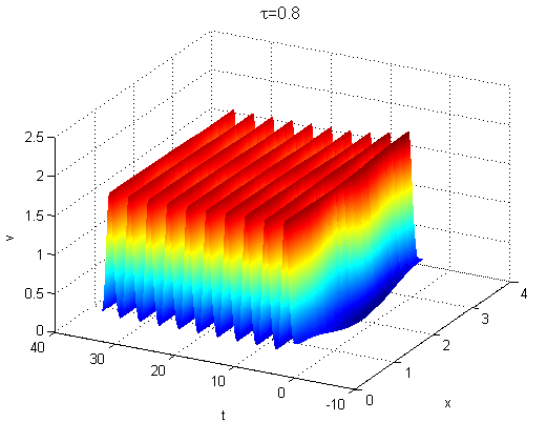
Figure 3. Numerical solutions of system (4). The initial conditions chosen were the following: v 0 = 0.25cos 2 x + 0.2. The parameters chosen were the following: m ( x ) = 1, K ( x ) = sin ( x ) + 2, α = 1, d = 2, τ = 0.8 > τ 0 ≈